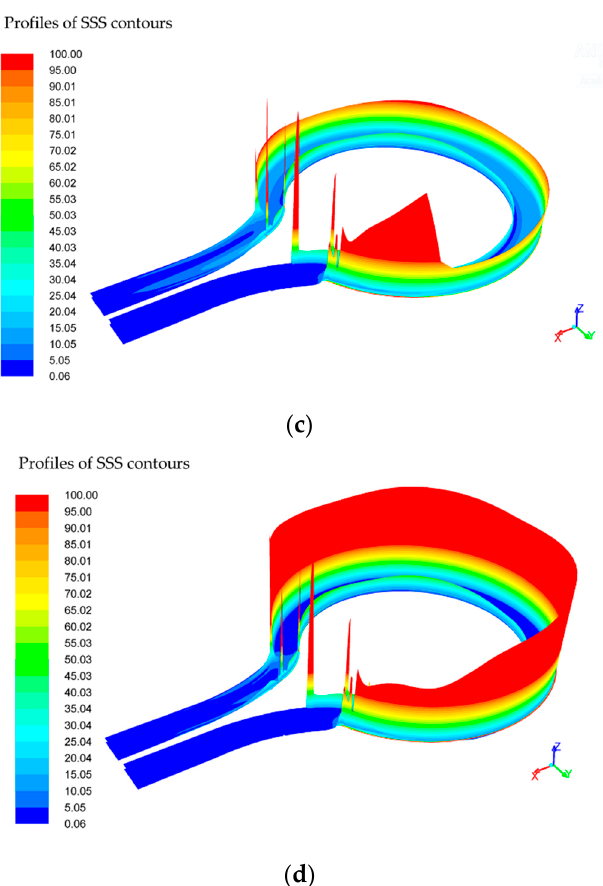
Figure 7. The scalar shear stress (SSS) (Pa) for computational domain: ( a ) a disk plane, z = 0 mm; ( b ) the offset plane, z = 0.05 mm; ( c ) the offset plane, z = 0.2 mm; ( d ) a central plane, z = 0.5 mm (central between disks).